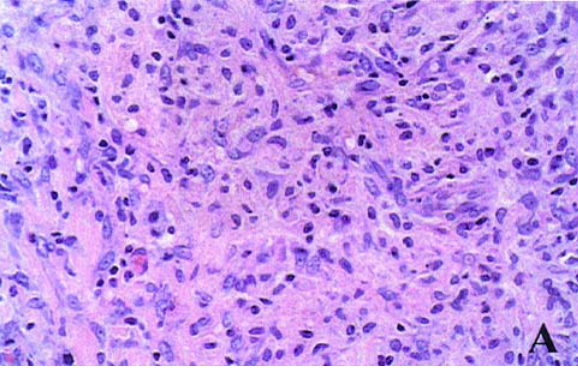
FIGURE 1- Photomicrography showing subcutaneous tissue response to empty collagen capsules (control group) at 10 days post implantation. Magnifications: x40 Hematoxylin and Eosin